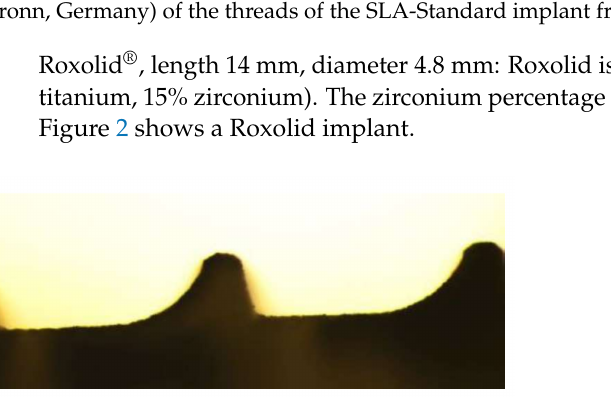
Figure 2. 2.5 × magnification with the microscope of the threads of the Roxolid implant from the Straumann